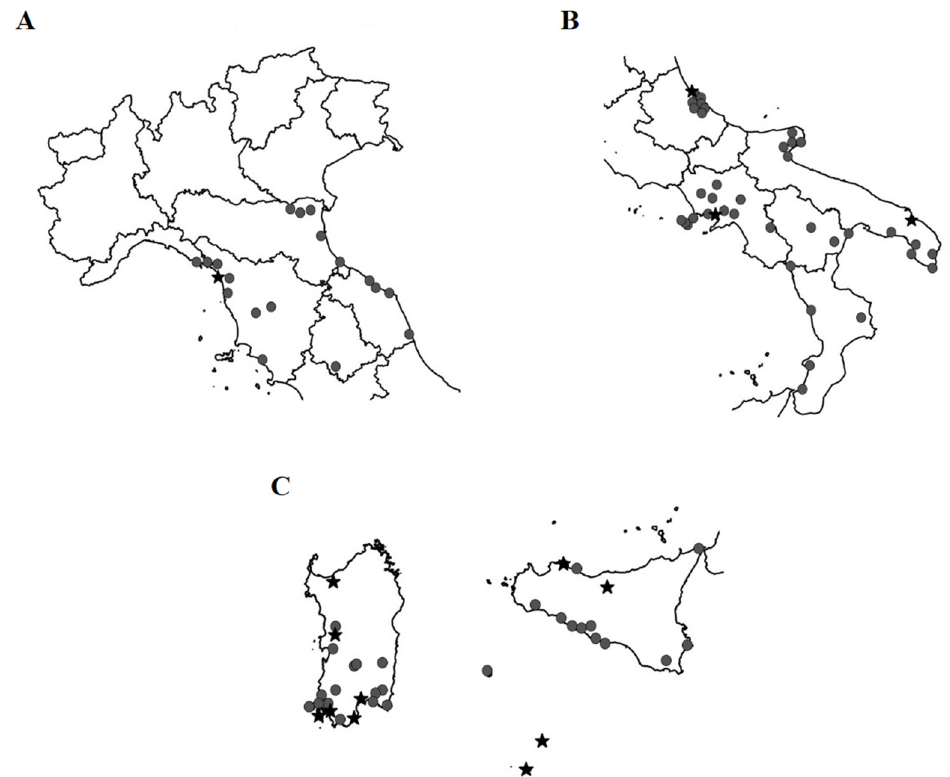
Figure 4. Italian localities where specimens of K. flavicollis were collected. ( A ) Northern Italy. ( B ) Southern Italy. ( C ) Sardinia, Sicily and minor islands. Circles, specimens collected in the wild. Stars, laboratory specimens presumably derived from individuals collected in the wild.